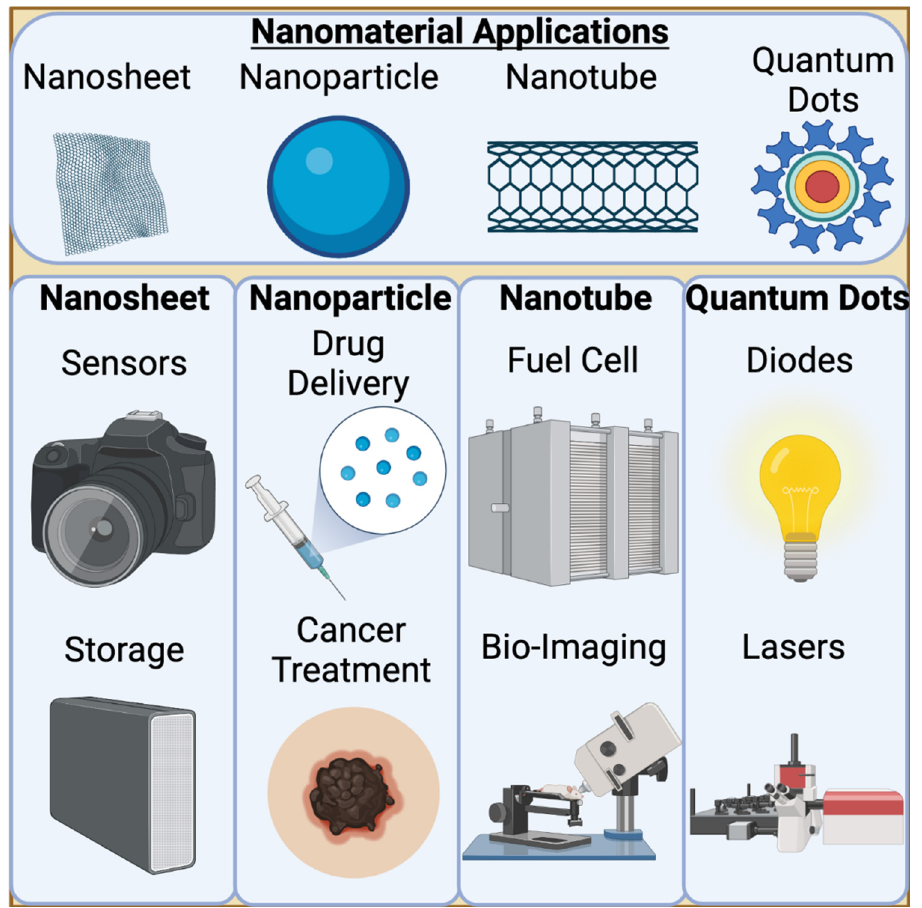
Figure 1. Applications of Nanomaterials. 0D and 1D nanomaterials have extensive applications throughout multiple sectors. Nanosheets, a 1D nanomaterial, are highly utilized in electronics as they can be highly conductive and sensitive. Nanoparticles are a 0D nanomaterial that are highly employed for drug delivery. Most notably, nanoparticle technology is used in the delivery of SARS- CoV-2 vaccines. Nanotubes are long, 1D nanomaterials that can vary in thickness depending on their application. For bio-imaging, single walled carbon nanotubes can be used to target specific tissues and emit a fluorescent signal bright enough to be detected. Finally, quantum dots, or buckyballs, vary slightly from nanoparticles in their composition. They are smaller and emit a light when excited, making them useful for lasers, amongst other applications.